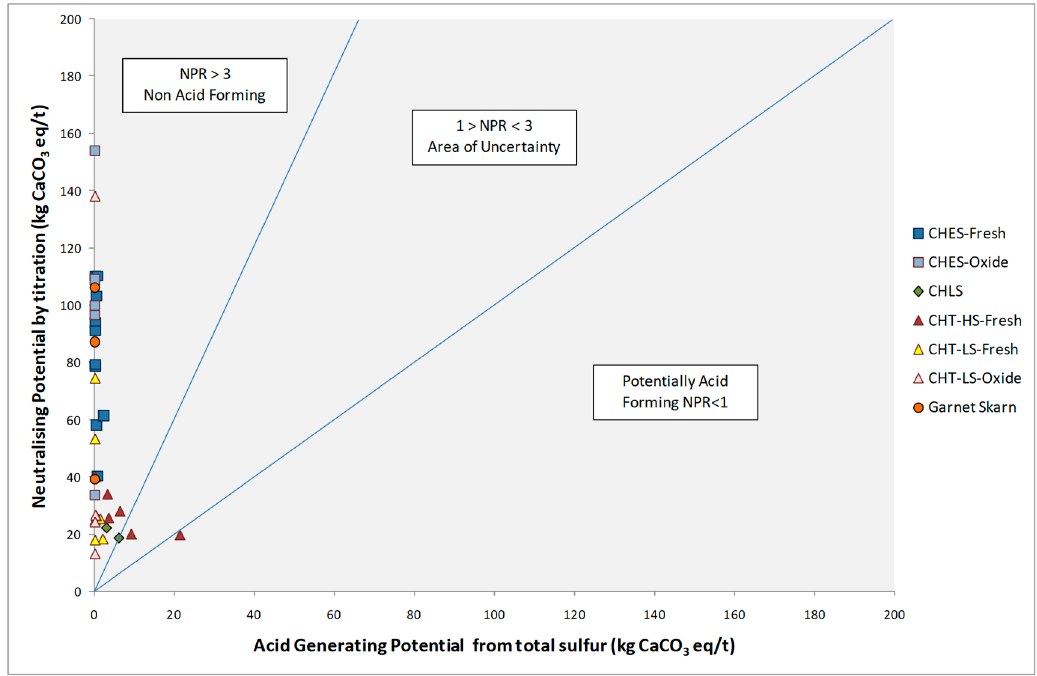
Figure 8. Scatter plot comparing acid generating potential and neutralising potential of the waste rock material.